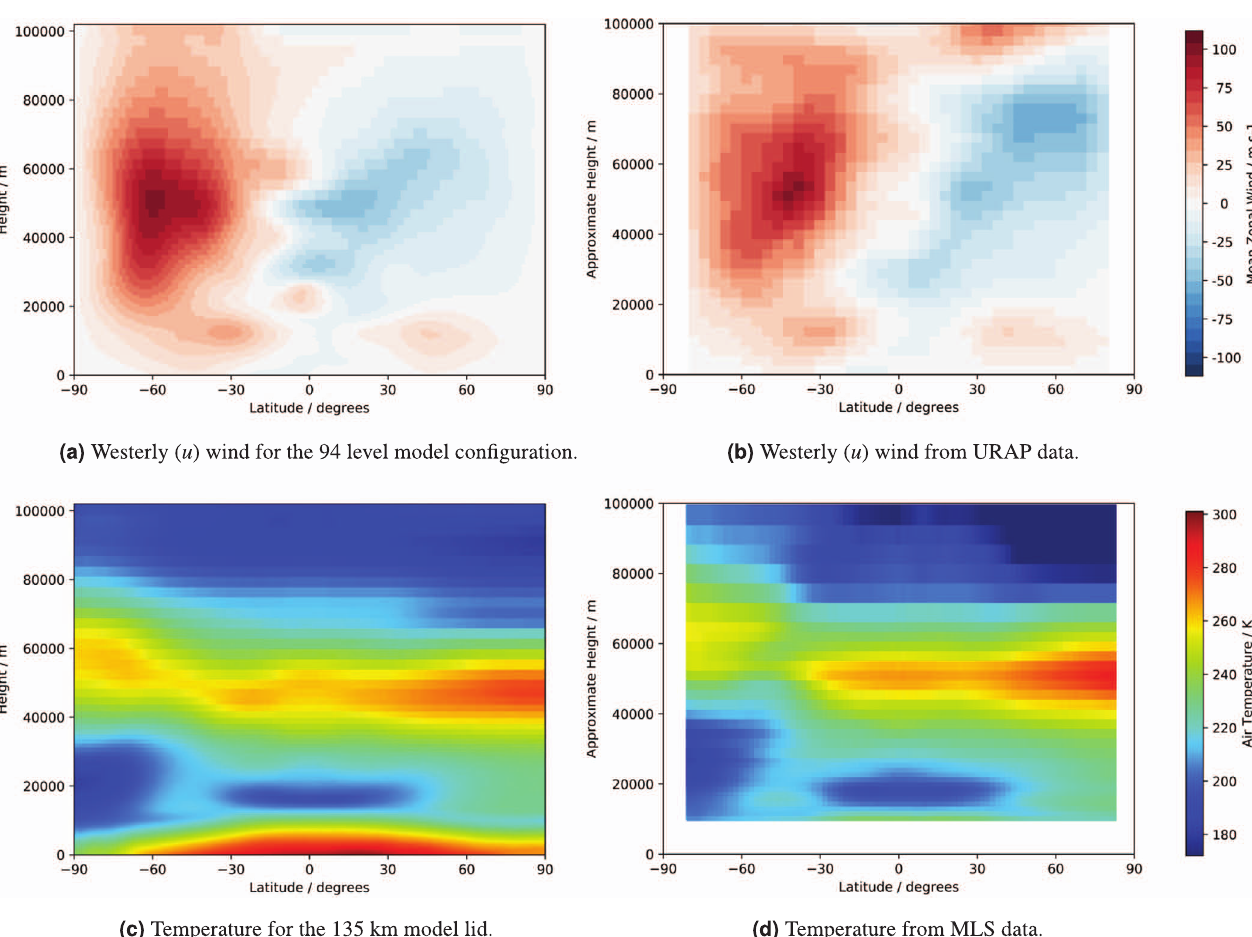
Fig. 15. Zonal mean monthly mean climatologies in June of westerly ( u ) wind (top) and temperature (bottom). These are compared to URAP data for zonal wind and MLS data for temperature. The approximate height is calculated using a scale height of H = 7200